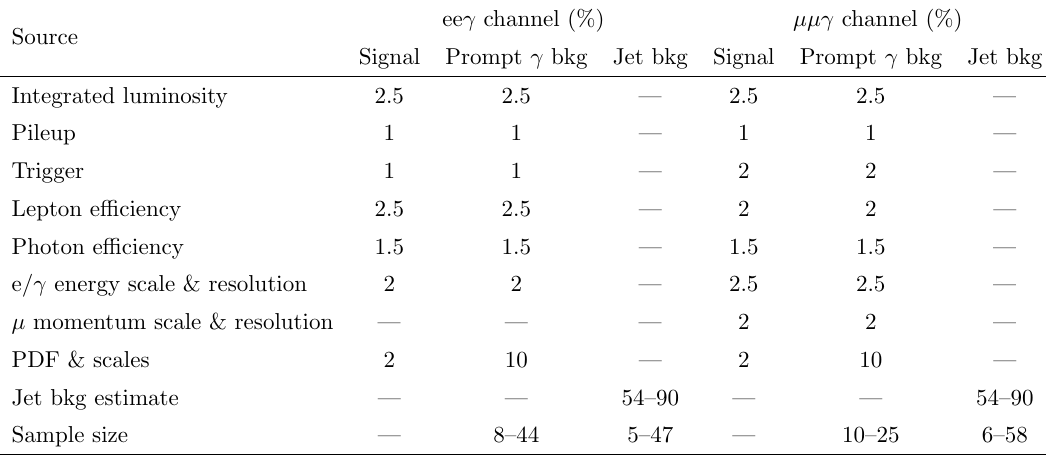
Table 1 . Summary of the systematic uncertainties (in %) in the signal yield, the prompt photon background prediction, and the jet background